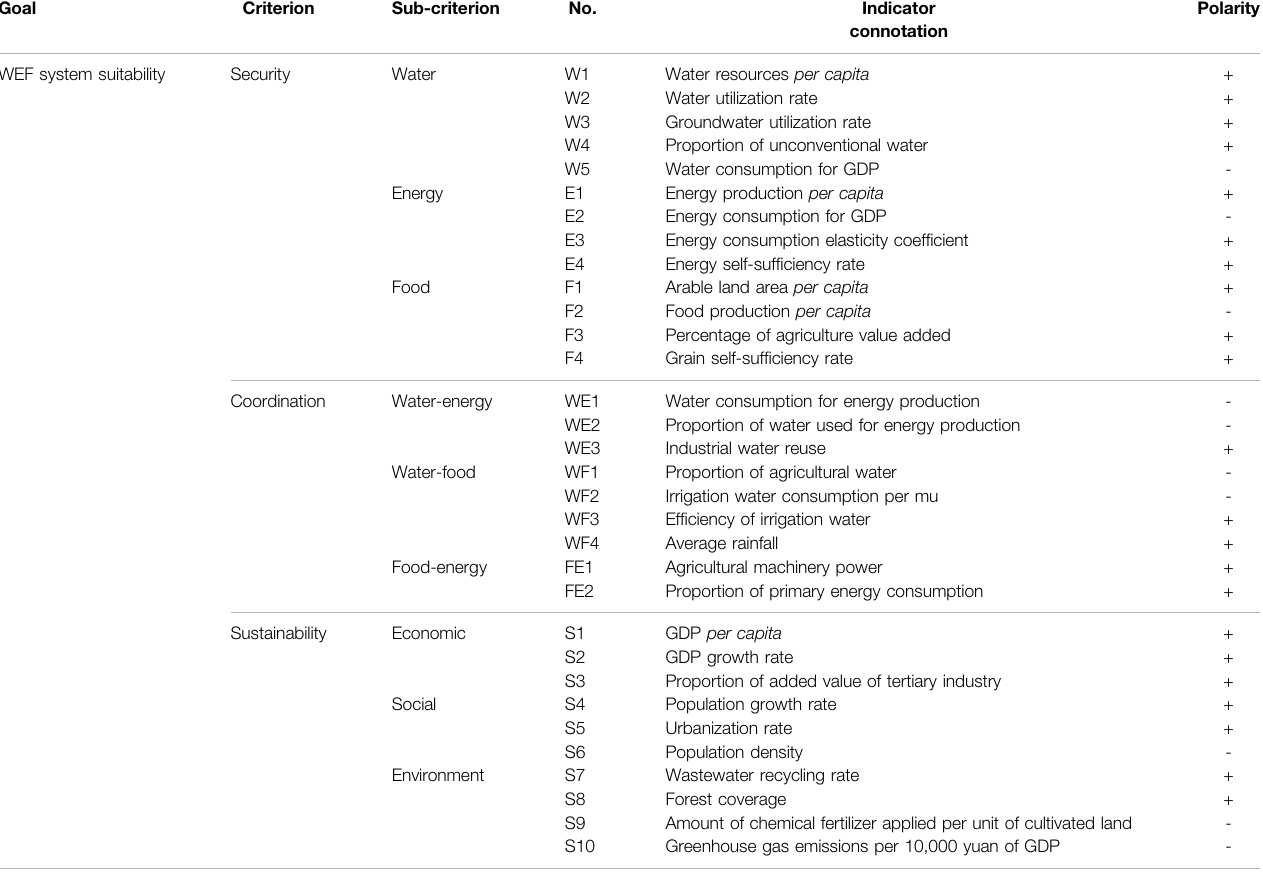
TABLE 1 | The indicators of water-energy-food system suitability evaluation.